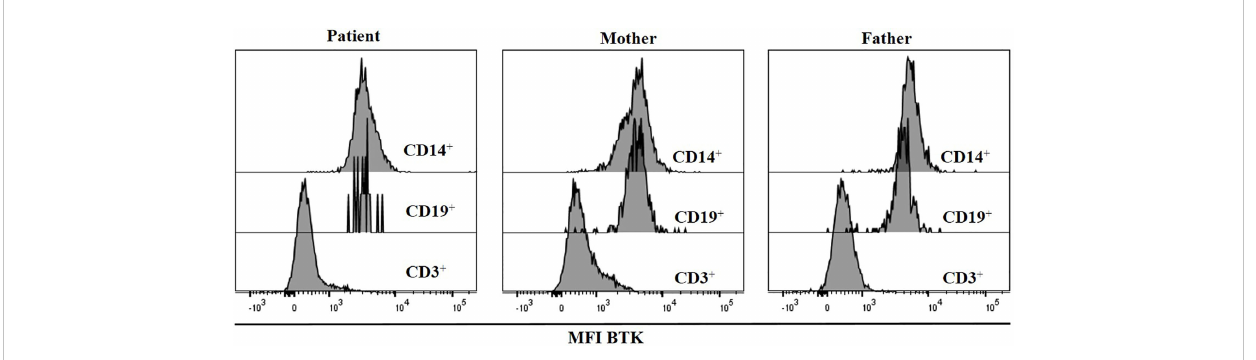
FIGURE 3 BTK expression was measured by fl ow cytometry. Histograms show BTK expression in CD19 + , CD3 + and monocytes, in the patient and his parents.